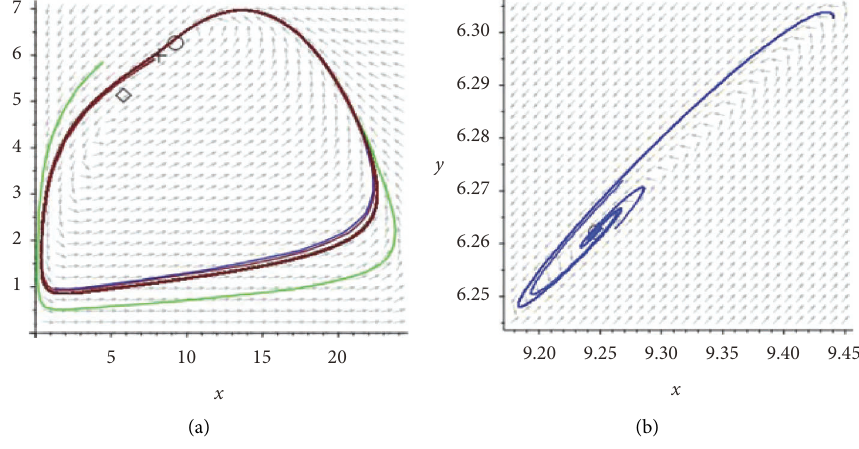
Figure 11: Phase diagrams in the case